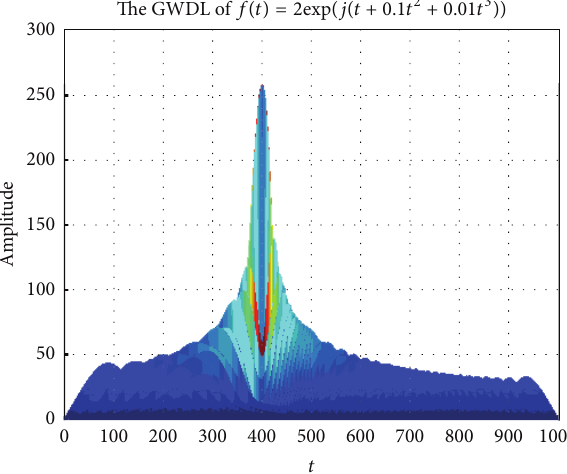
Figure 2: 𝑡 -amplitude distribution of QFM signal in GWDL domain.